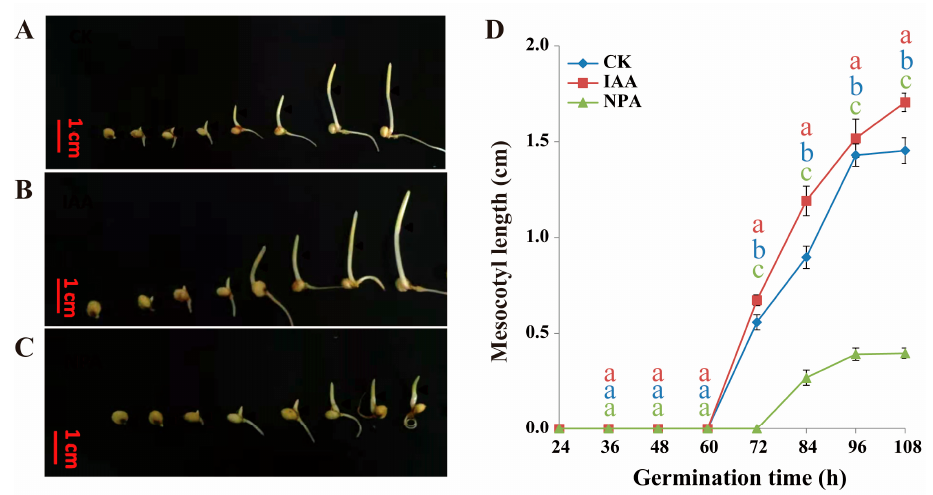
Figure 1. Mesocotyl length at different germination time in line MS24B. ( A ) Mesocotyl morphology phenotype at 24 h, 36 h, 48 h, 60 h, 72 h, 84 h, 96 h, and 108 h of line MS24B; ( B ) Mesocotyl mor- phology phenotype at each timepoint of line MS24B with exogenous IAA application; ( C ) Mesocotyl morphology phenotype at each timepoint of line MS24B with exogenous IAA and NPA application; ( D ) Line graph of mesocotyl length of three treatments at each timepoint of MS24B. All data present the mean ± SD of three independent experiments. Lowercase letters indicate statistical differences ( p ≤ 0.05) among treatments.